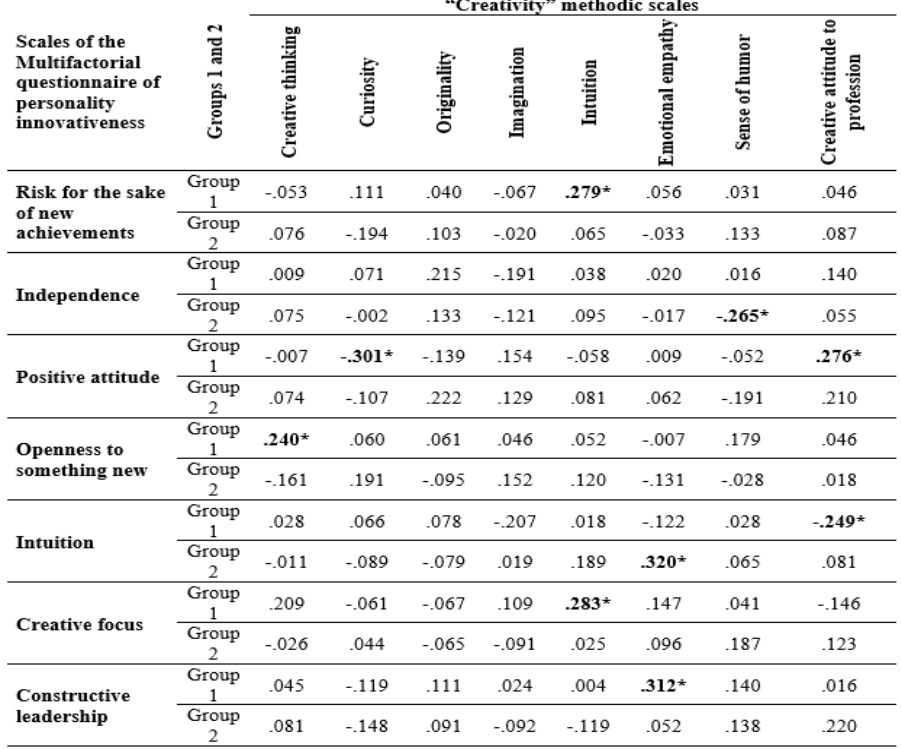
Table 2. The results of correlation analysis by the methods of MQPI and "Creativity" by N. Vishnyakova in groups with different levels of involvement